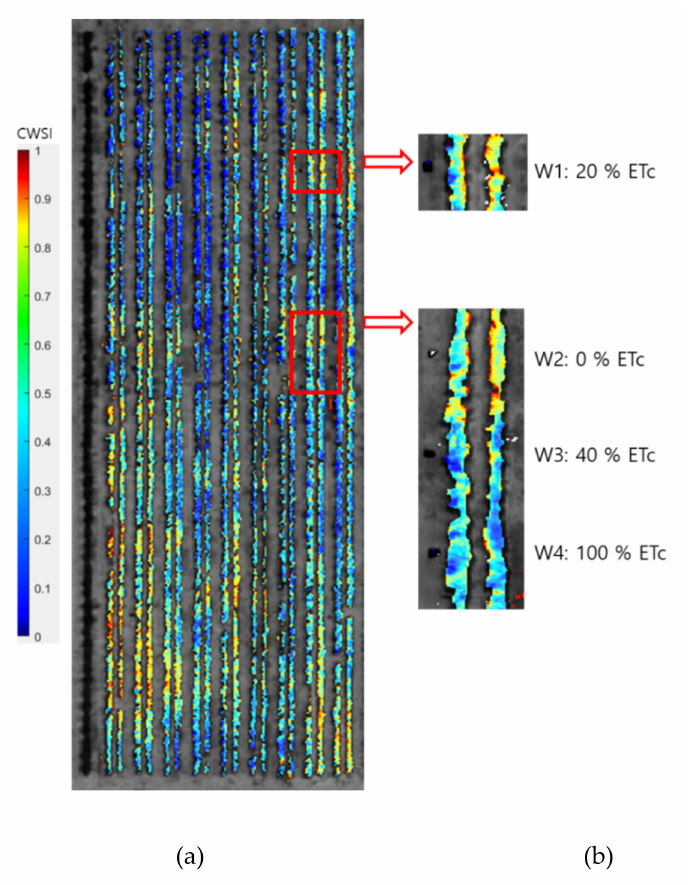
Figure 3. ( a ) Adaptive CWSI map derived from midday UAV remote sensing for the entire exper- imental nectarine orchard, Tatura. The red rectangles represent the area of irrigation treatments. ( b ) Detailed adaptive CWSI map depicting the experimental plots of W1 (20 % ETc), W2 (0 % ETc), W3 (40 % ETc) and W4 (100 % ETc).